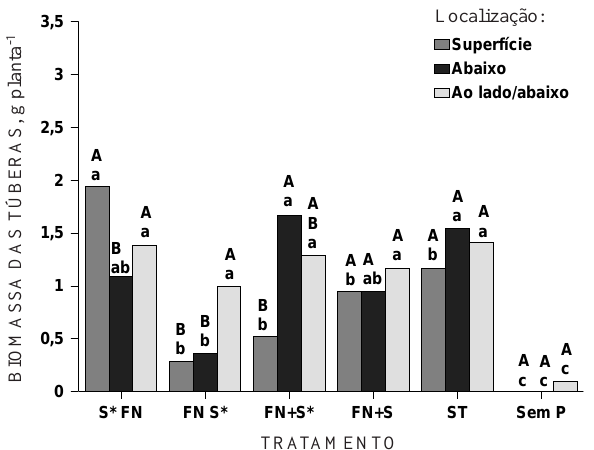
Figura 4. Biomassa das túberas nos tratamentos FN revestindo o enxofre inoculado com Acidithiobacillus (FN S*), FN revestido com S inoculado com Acidithiobacillus (S* FN), mistura FN com S inoculado com Acidithiobacillus (FN + S*), mistura FN com S sem Acidithiobacillus (FN + S), superfosfato triplo (ST) e sem adição de fósforo (sem P) de acordo com a localização do adubo. Letras minúsculas comparam as médias dos diferentes tratamentos com adição de P em cada modo de localização do adubo; as maiúsculas, cada tratamento com P nos diferentes modos de localização do adubo. C.V. % =